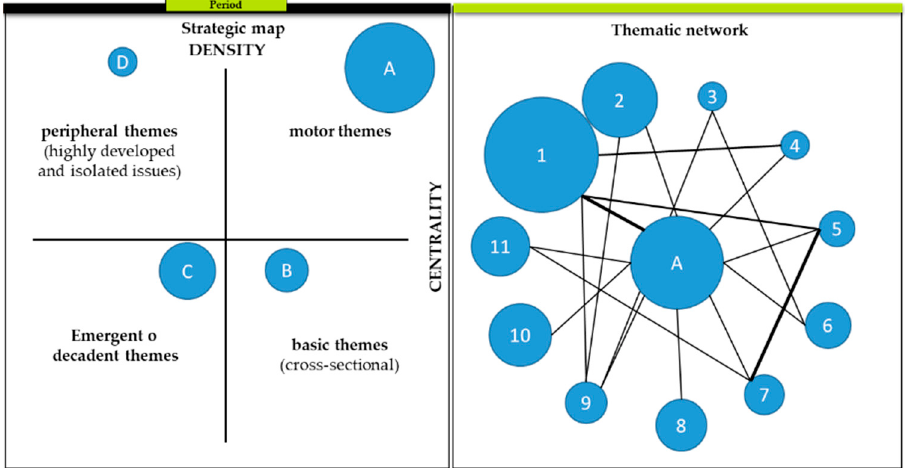
Figure 2. Example of a strategic map and thematic network. Source: Prepared by the authors based in Cobo [77].